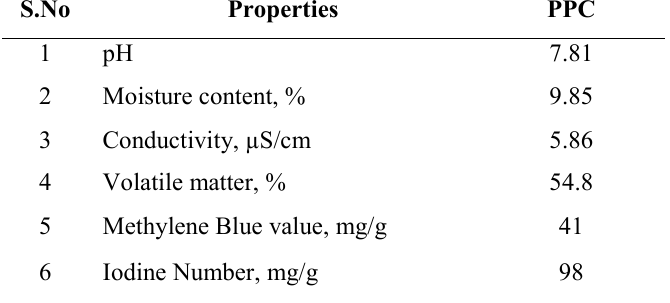
Table 1 - Physico-chemical characteristics of Poly Pyrrole